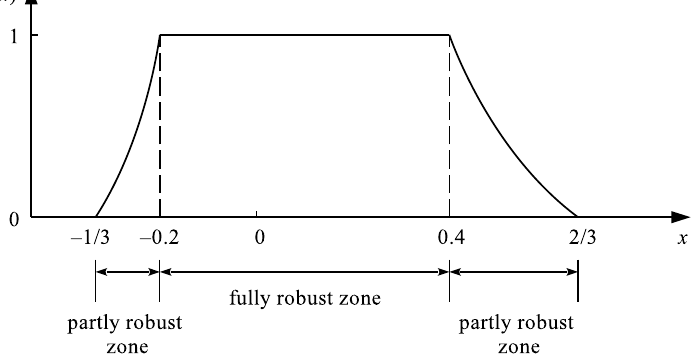
Figure 11. Robustness distribution r ( x ) of the tolerance control of the system [ 3,5 ] x = [ − 1,0,2 ]